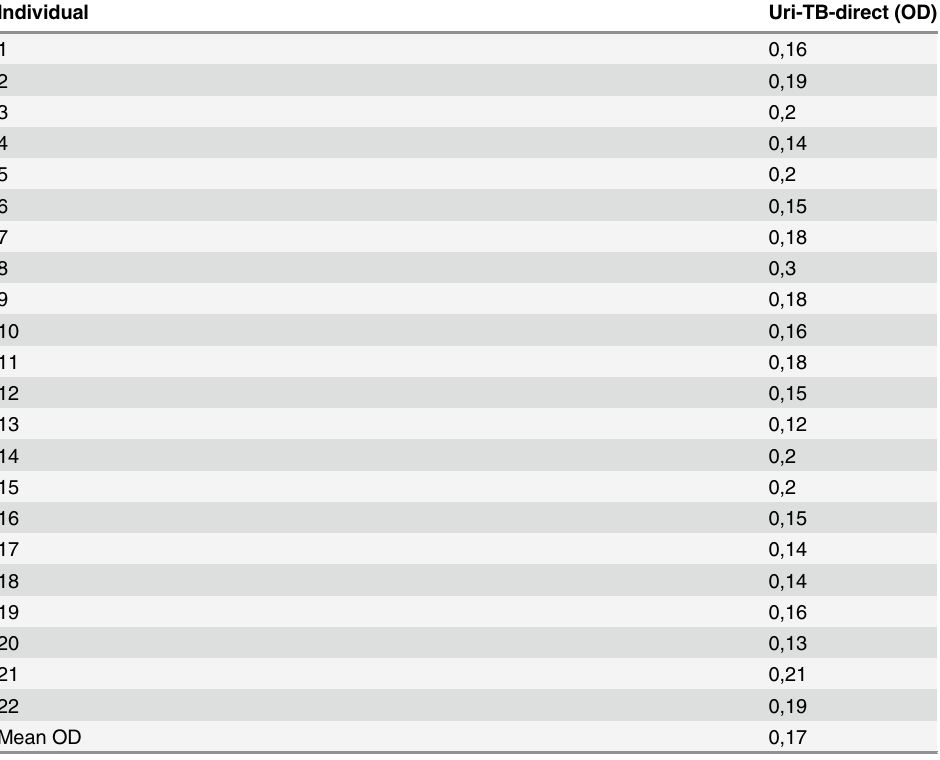
Results in optical density (OD) at absorbance 450